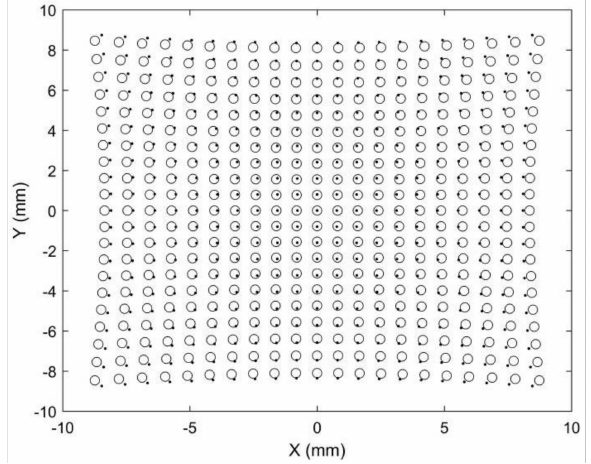
Figure 5. Simulated image points after anamorphic ration ( AR ) expansion. The dot points are rectified horizontally by AR , and the circle points are rectified vertically by AR .